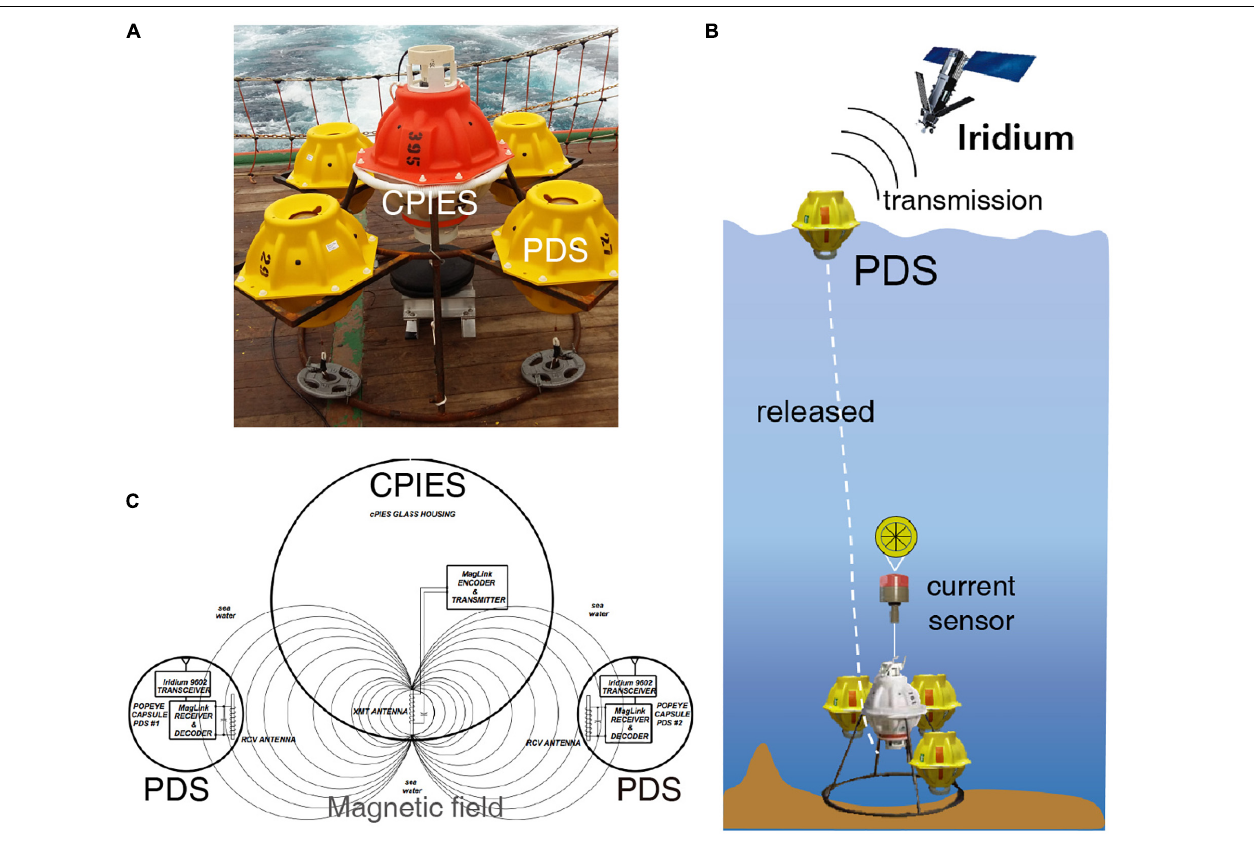
FIGURE 1 | (A) Assembled PDS-CPIES on RV Araon . (B) Concept of PDS operation. (C) Concept of subsea wireless link using magnetic field between CPIES and PDS (selected from PDS manual). PDS, pop-up data shuttle; CPIES, current- and pressure-recording inverted echo